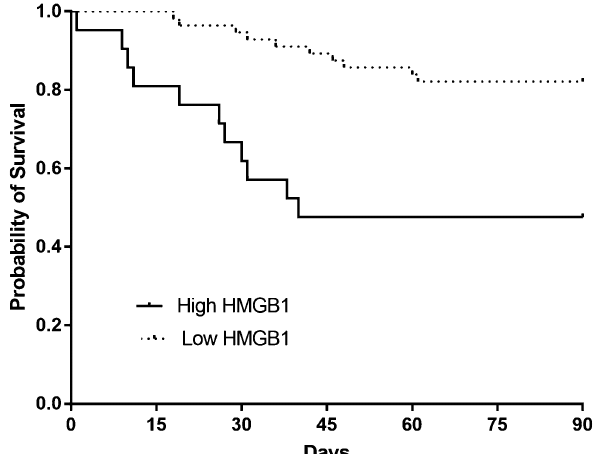
Figure 5. Kaplan–Meier survival analysis comparing patients of validation cohort with high- and low-plasma levels of HMGB1 (n = 77) ( P < 0.001, log-rank